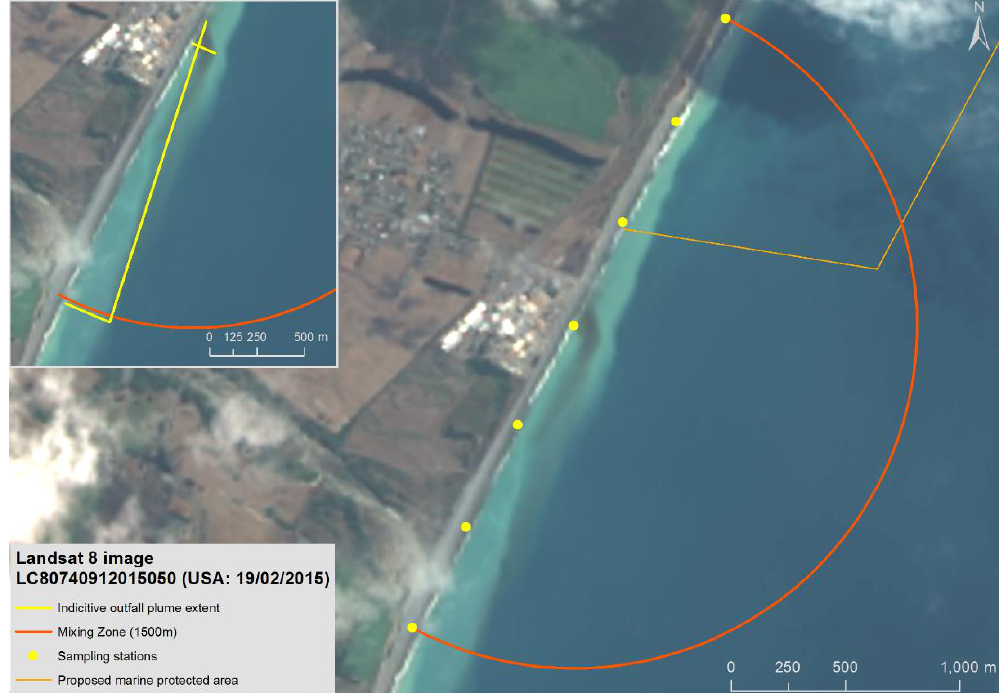
Figure 10. Landsat 8 satellite image (captured USA time: 19 February 2015) showing diffuse plume extending to the south, slightly beyond the mixing zone boundary.